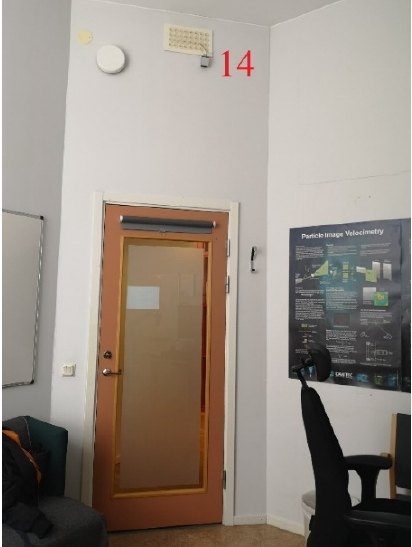
Figure 12. Placement of logger 14 (at the supply inlet) in Room C.